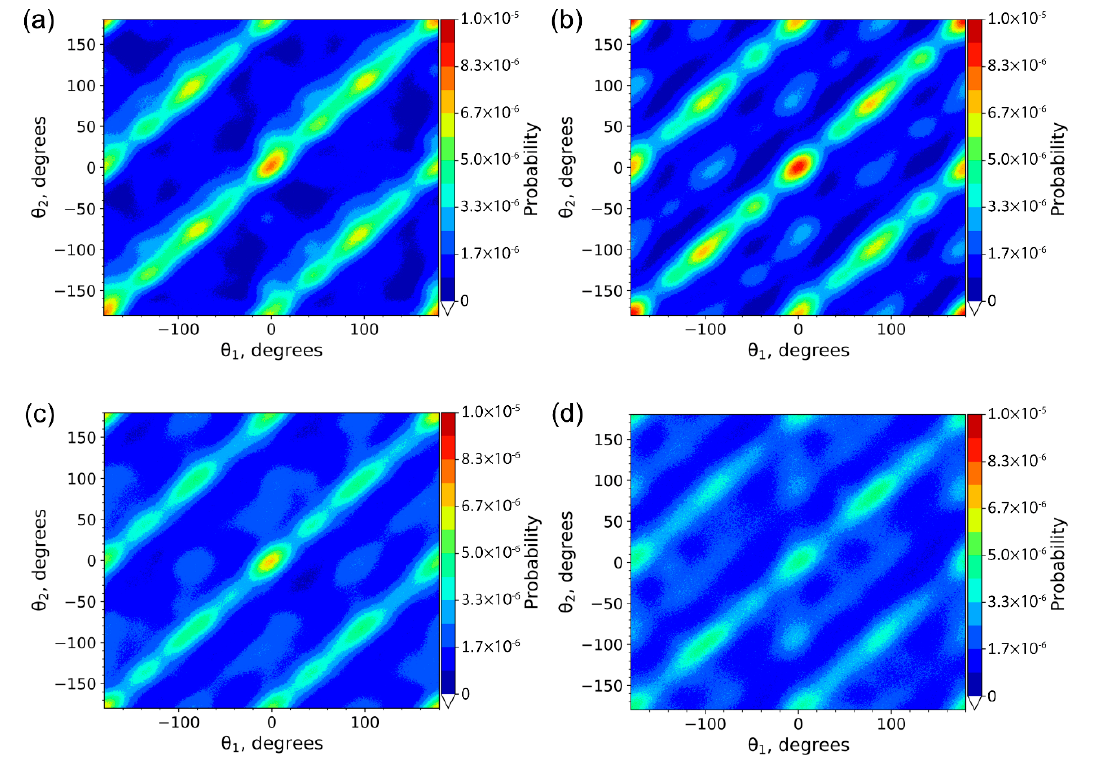
Figure 7. The probability distribution P ( θ 1 , θ 2 ) for n-eicosane crystalline samples cooled down with the rate of ( a ) 6 × 10 9 K/min, ( b ) 6 × 10 10 K/min, ( c ) 1.2 × 10 11 K/min, and ( d ) 6 × 10 11 K/min. Temperature is set to 250 K.